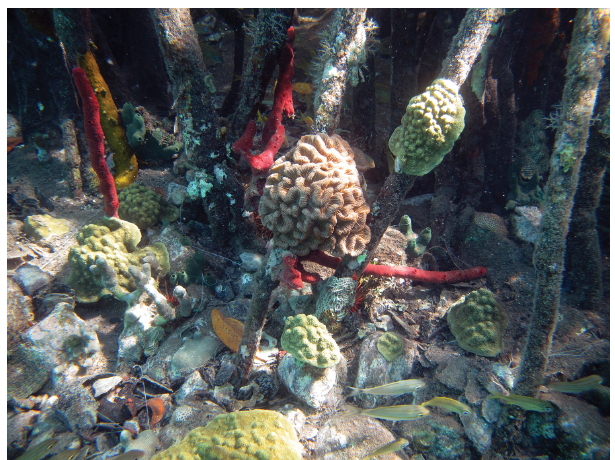
Figure 2. Corals growing under a mangrove canopy and attached to mangrove prop roots including a colony of Colpophyllia natans (center of